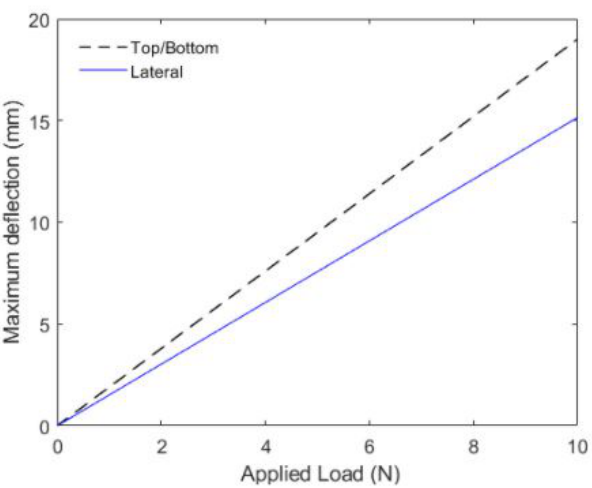
Figure 3. Maximum deflection of the simply supported optical fiber under effect of a load applied on its longitudinal center. The figure shows the values for the lateral section on the top/bottom and lateral side of the